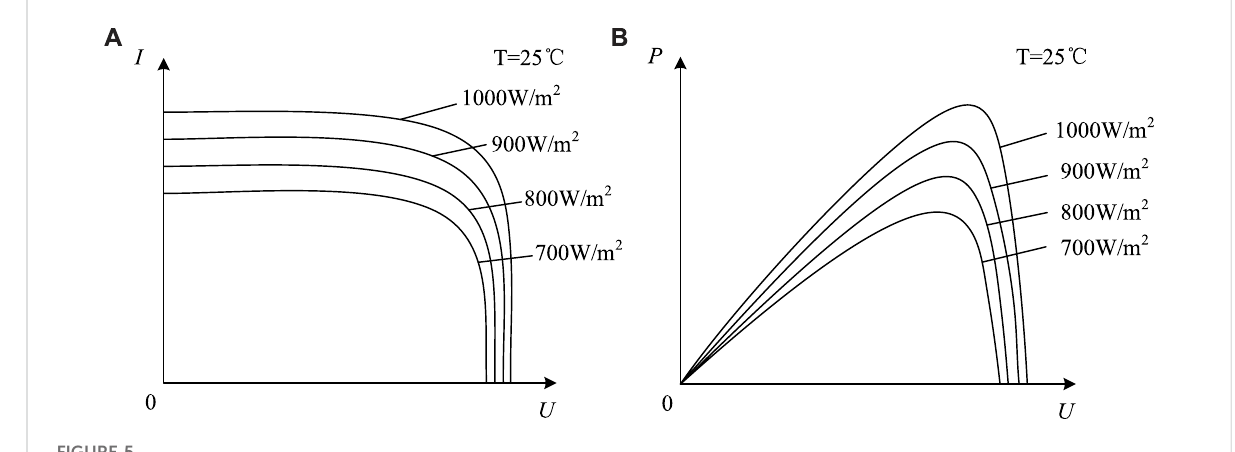
FIGURE 5 Output characteristics of photovoltaic cells under the same temperature and different light intensities. (A) Voltammetry characteristic curve. (B) Power voltage characteristic